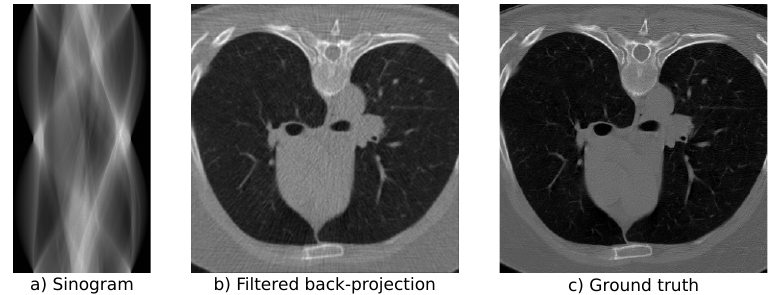
Figure 4. Reconstruction and measurements for the low-dose LoDoPaB-CT